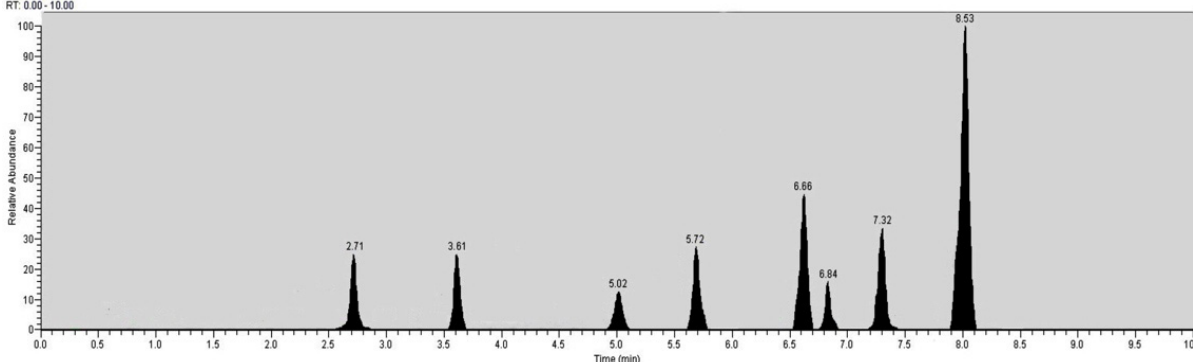
Figure 1. Representative Liquid Chromatography/MS(Orbitrap TM ) chromatogram.